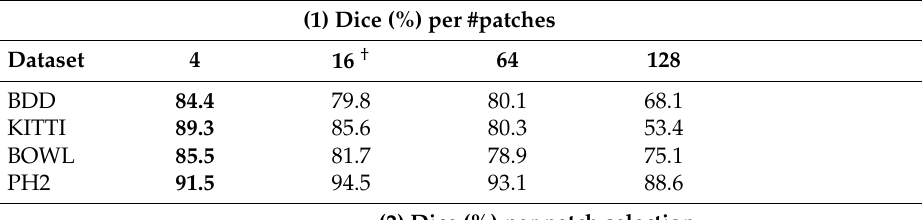
Table 4. Ablation studies for several parts of the proposed method (best results in bold). DeepLab is used as the